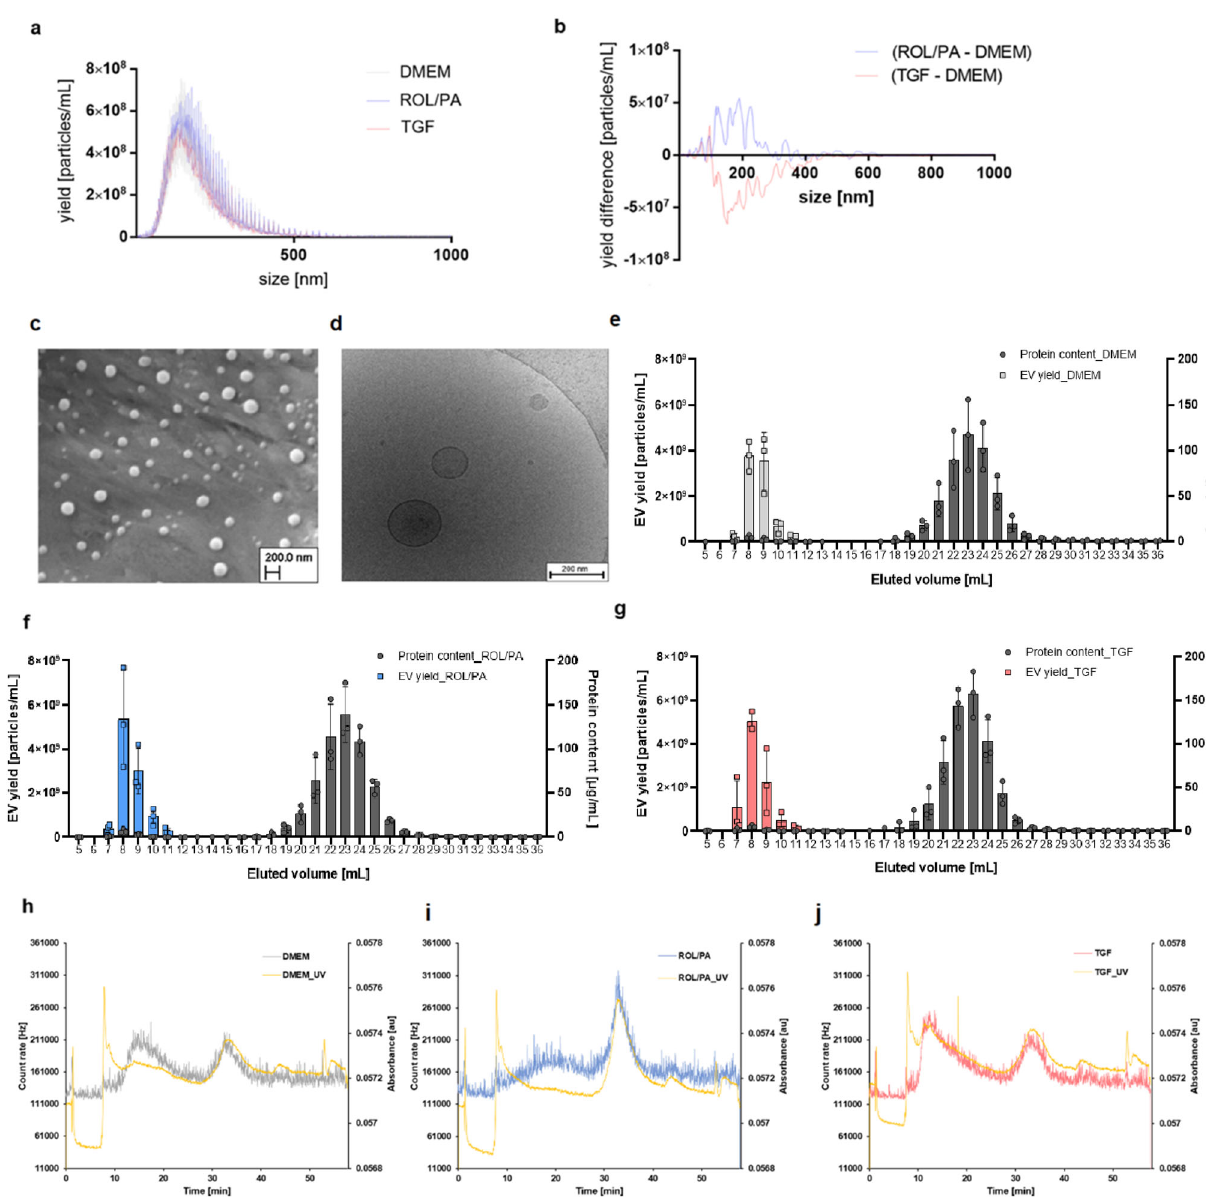
Fig. 2 Isolation and characterization of EVs from LX-2 cells. a Size distribution pro fi les of EVs isolated from differently treated cells (mean ± SD, n = 3). b Quantile subtraction of the yields. c , d SEM ( c ) and cryo-TEM ( d ) images of EVs isolated from untreated cells. e – g Protein content and vesicle number in the collected SEC-fractions obtained from untreated ( e ), quiescent ( f ), and perpetuated ( g ) LX-2 (mean ± SD, n = 3). h – j Representative EAF4 fractograms of EV collected from untreated ( h ), quiescent ( i ), and perpetuated ( j ). COMMUNICATIONS BIOLOGY| (2022) 5:1155